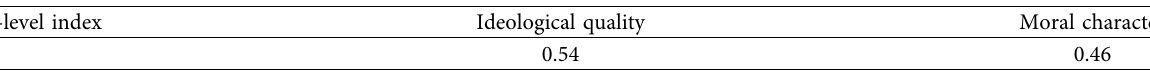
Table 11: F j of ideological and moral quality.